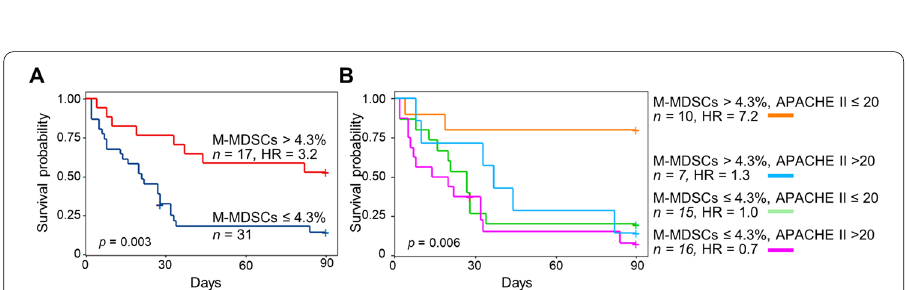
Fig. 4 Kaplan–Meier 90‑day survival curves based on low and high levels of M‑MDSCs ( leukocytes) ( A ) and on the combination of low and high levels of MDSCs and low and high APACHE II scores ( 20 and > 20) ( B ). Statistical differences were assessed using the log‑rank ≤